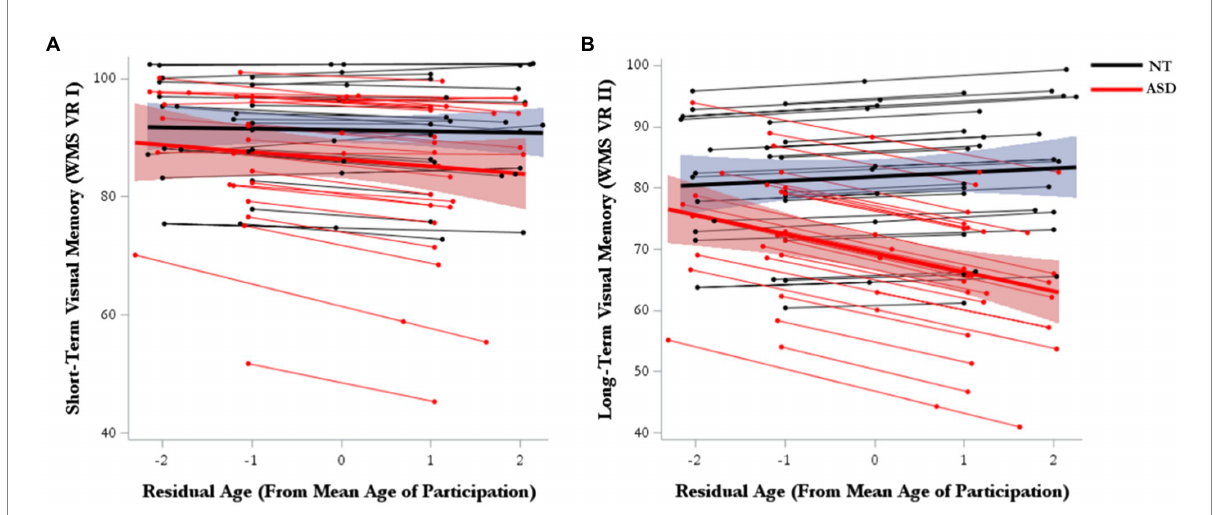
FIGURE 2 Model-predicted marginal and subject-level trajectories of change over time in (A) visual short-term memory and (B) visual long-term